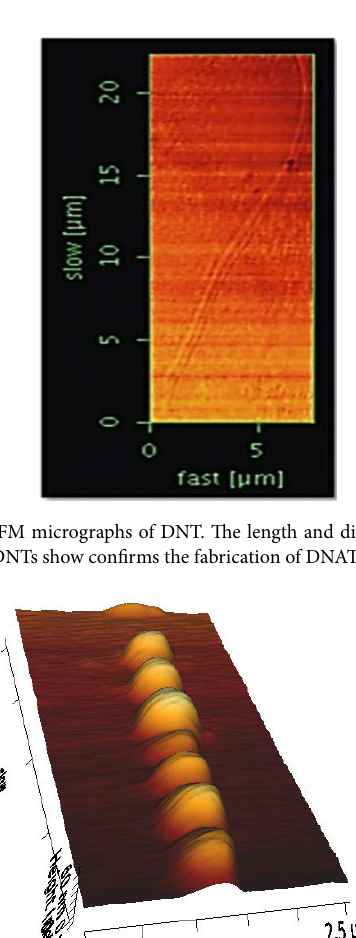
biotinylated oligo-aptamers.